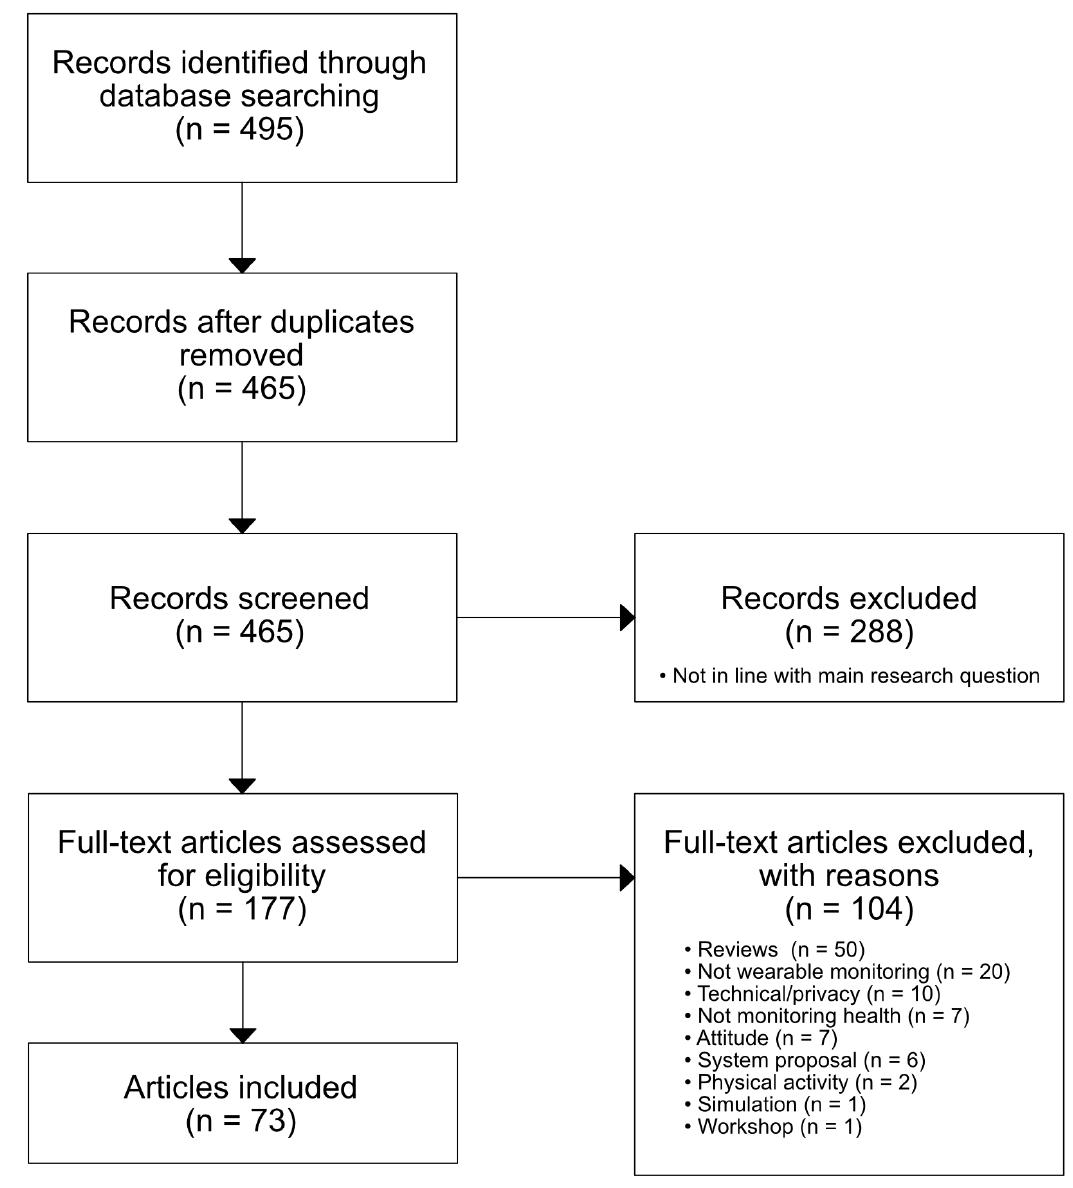
Figure 1. The article selection